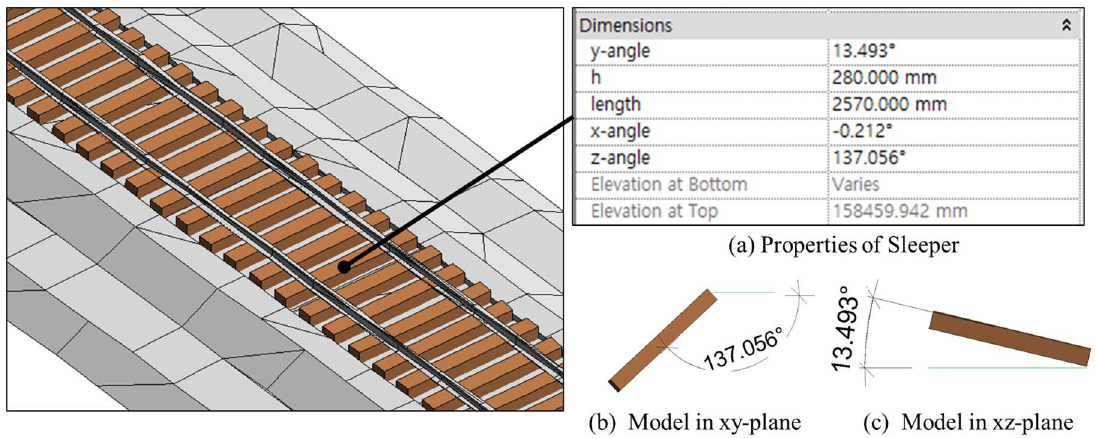
Figure 10. An example of the information model of discontinuous objects: ( a ) Properties of a sleeper; ( b ) model in the xy-plane; and ( c ) model in the xz-plane.